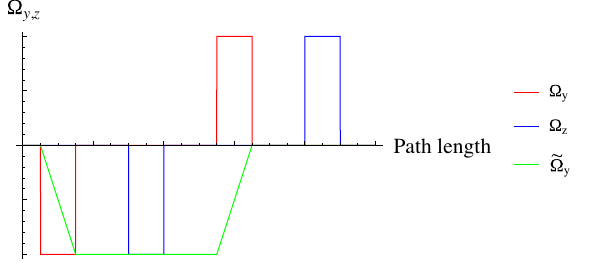
FIG. 7. Illustrations of the longitudinal and vertical components of the spin precession vector due to alternating longitudinal and vertical magnetic field imperfections. The vertical tilde compo- ˜ Ω nent represents the integral of the vertical component and y accounts for the rapidly oscillating terms of the radial spin component. The average of the product of nonvanishing vertical spin component.